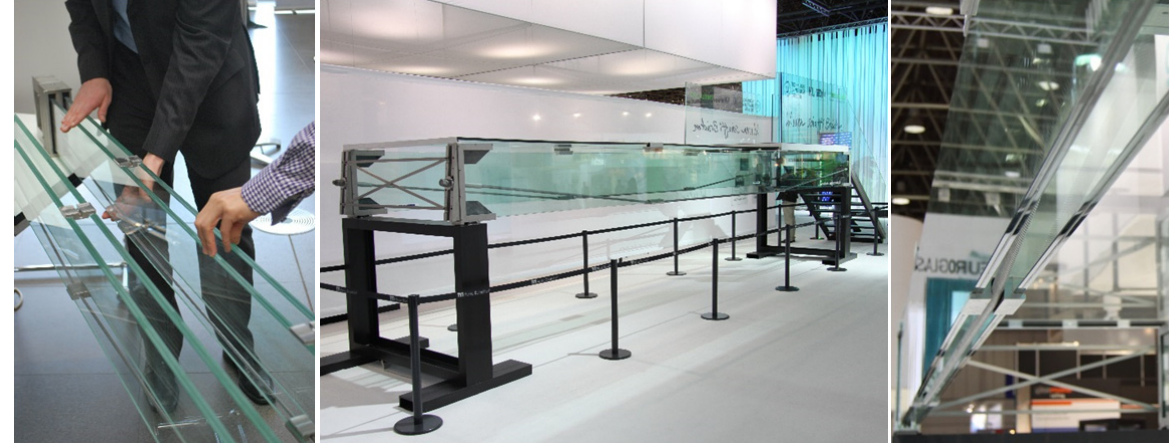
Fig. 1 Spannglass-Beam Mock-ups. A large-scale 9,0 m pedestrian bridge at glasstec 2014 in Düsseldorf,